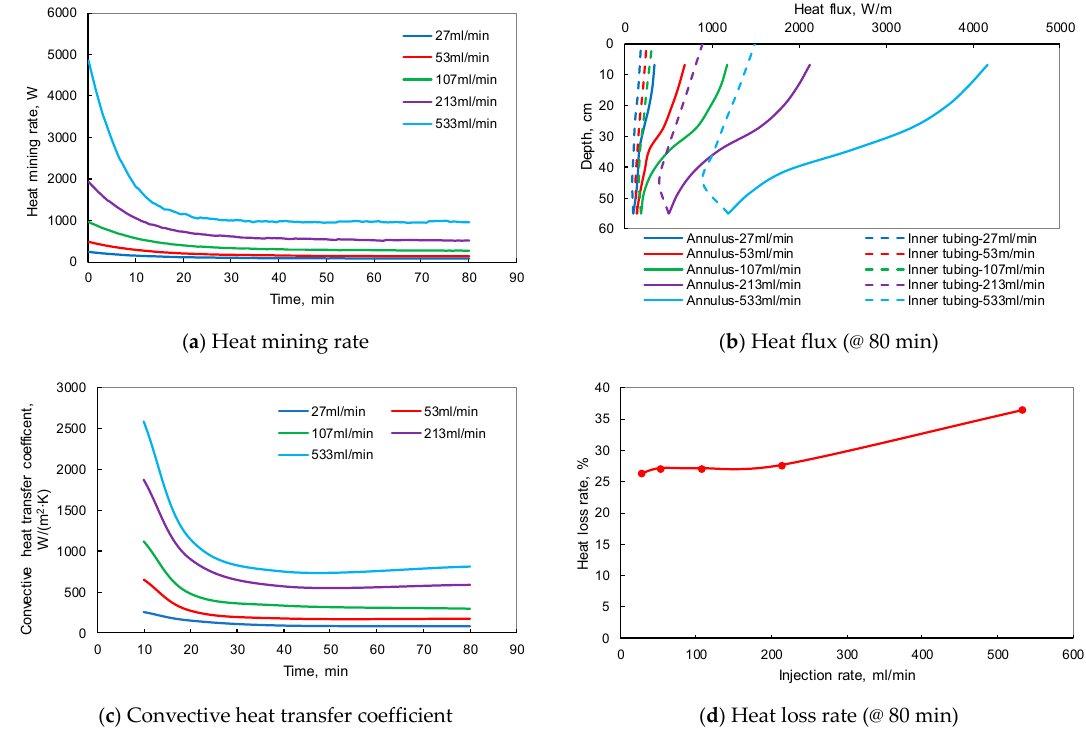
Figure 15. The main heat exchange parameters at different injection rates.